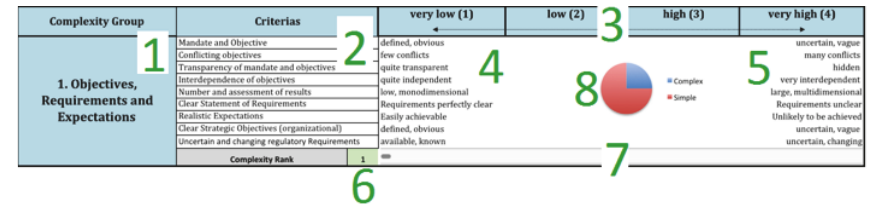
Figure 5: Complexity group functional